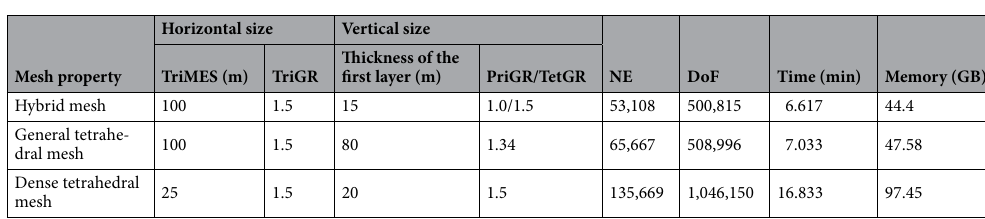
Table 5. Parameters of different meshes for the terrain relief